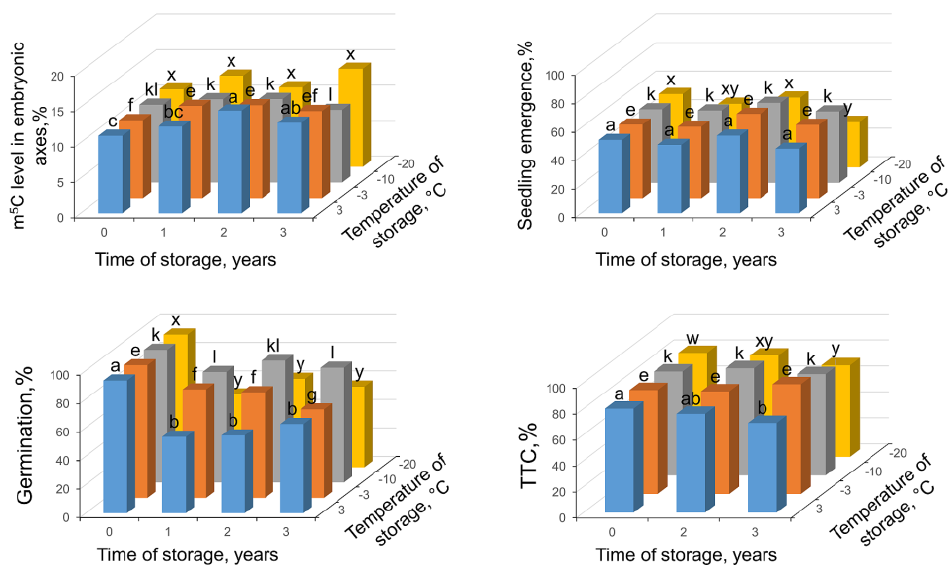
Figure 6. Changes in m 5 C in embryonic axes, seedling emergence, germination capacity, and viability in measured TTC assay in Fagus sylvatica L. seeds desiccated to MC of 7.6% and subsequently stored at four various temperatures (3, − 3, − 10, − 20 ◦ C) for one, two, and three years. Values labeled with different letters are significantly different at p ≤ 0.05, ANOVA, Tukey test. Data represent the mean ± se ( n = 5).